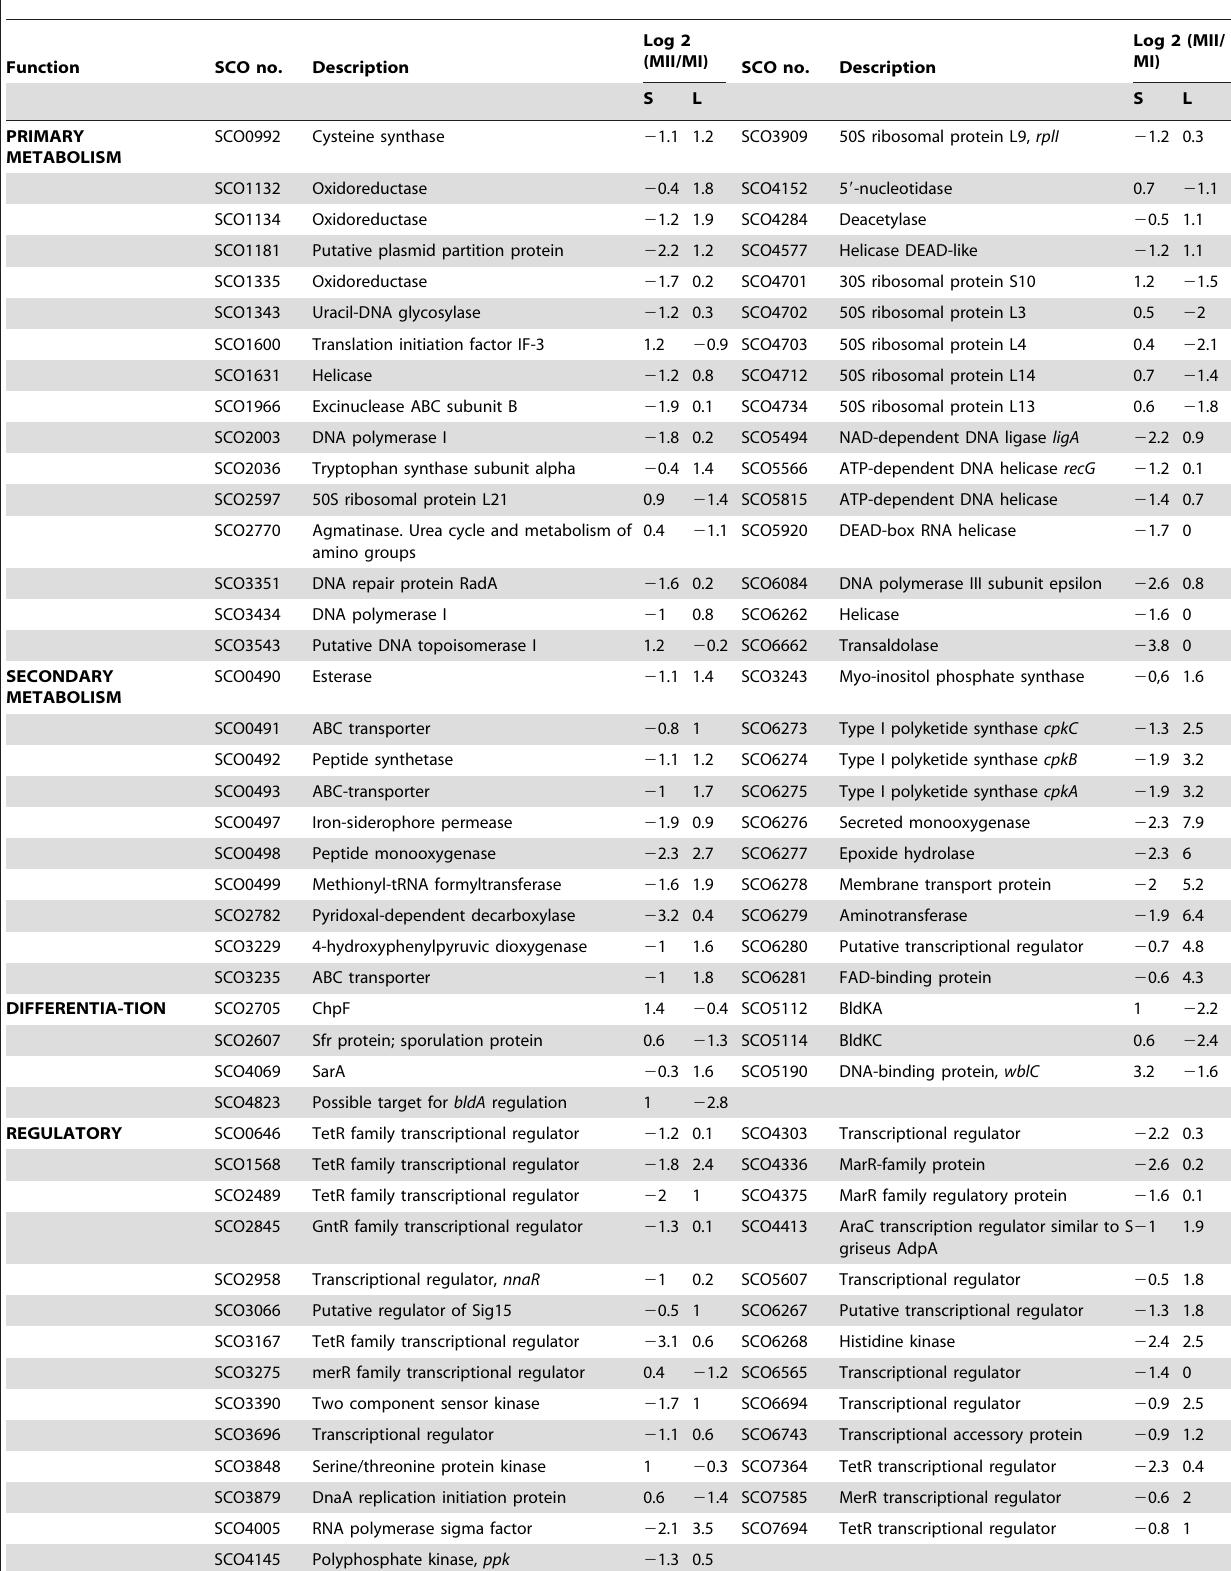
Table 1. Transcripts showing opposite (positive values in solid and negative in liquid or vice versa ) and significant (coefficient of variation between solid and liquid cultures higher than 0.7) abundances (Fig. 4C, F, I, L, O, R, U; Fig. 5C, F, I, L).